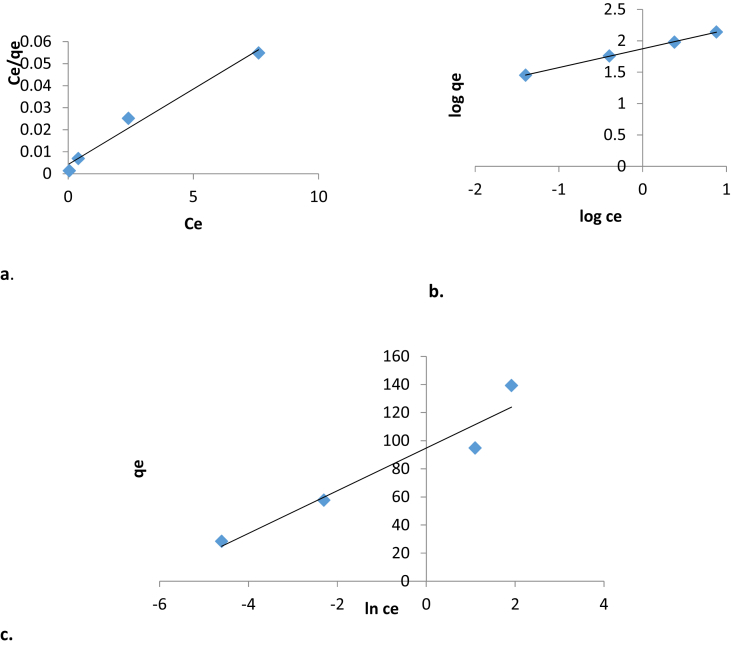
Plots for (a) Langmuir, (b) Freudlich and (c) Temkin isotherms for Pb2+ adsorption on acid activated Aloji clay at 30 °C.